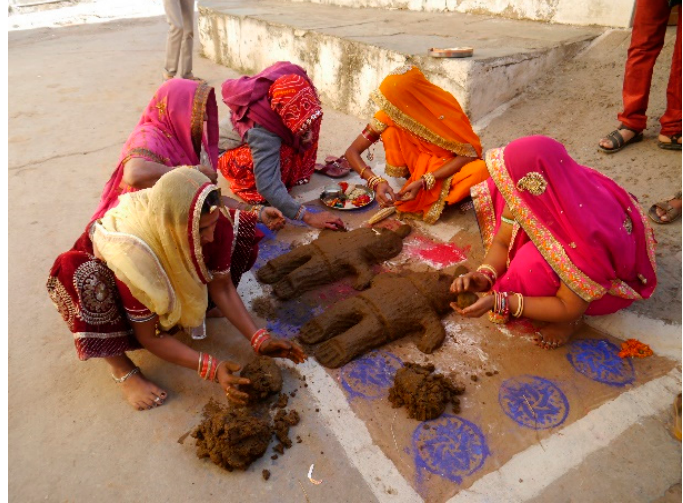
Figure 5. Women kneading Govardhan on top of the cow dung-painted canvas and the brightly coloured rangoli’s, Badi 2017 (picture by author).